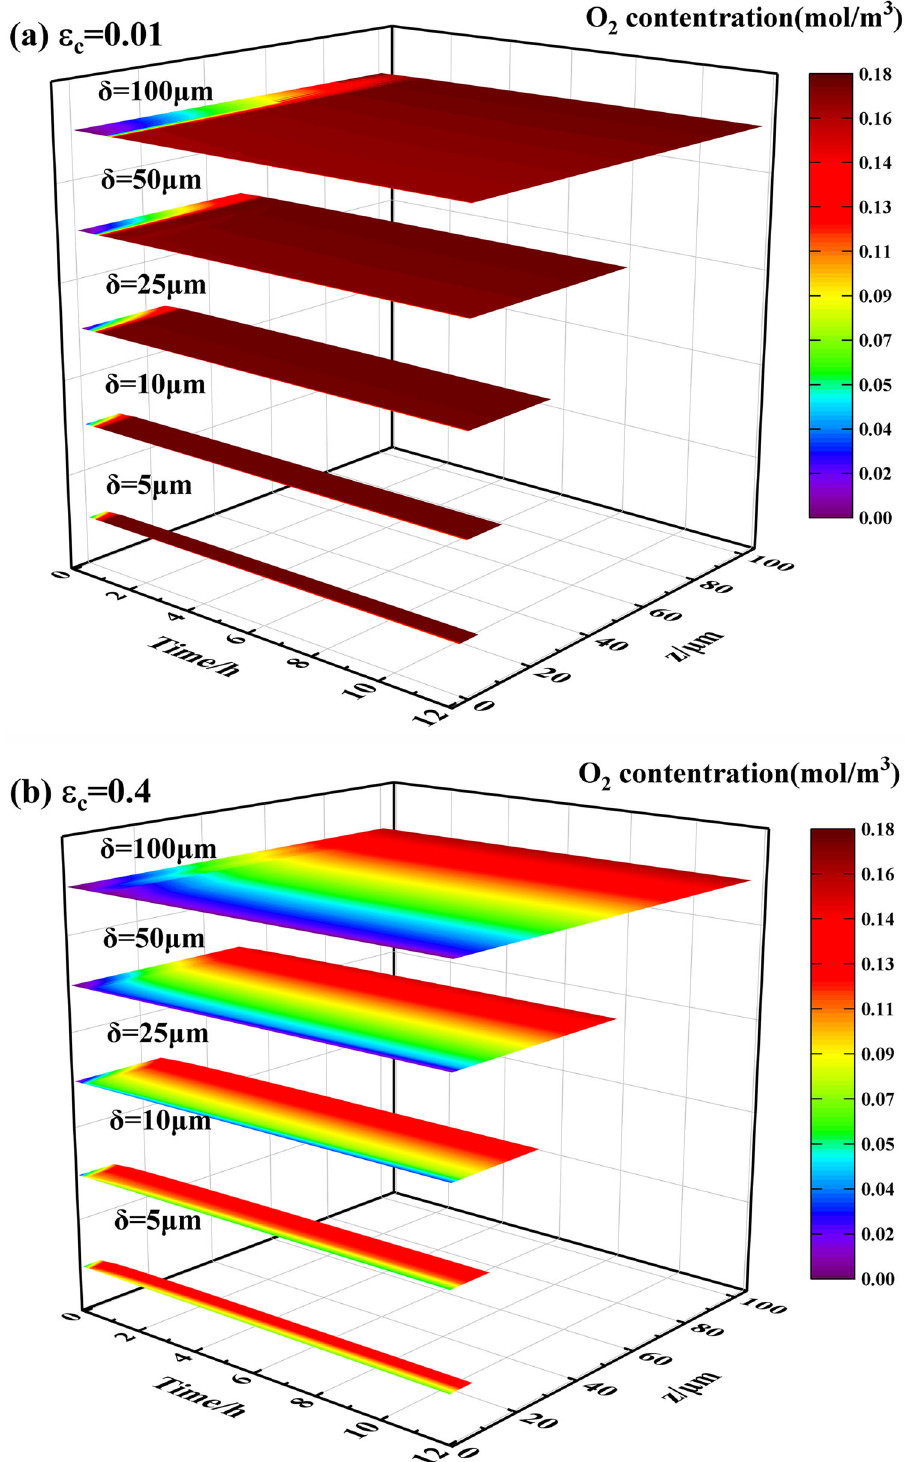
Fig. 4 Time evolution of O 2 concentration along the longitudinal distribution under electrolyte fi lm with different thicknesses. a the ε c of corrosion products is 0.01. b the ε c of corrosion products is